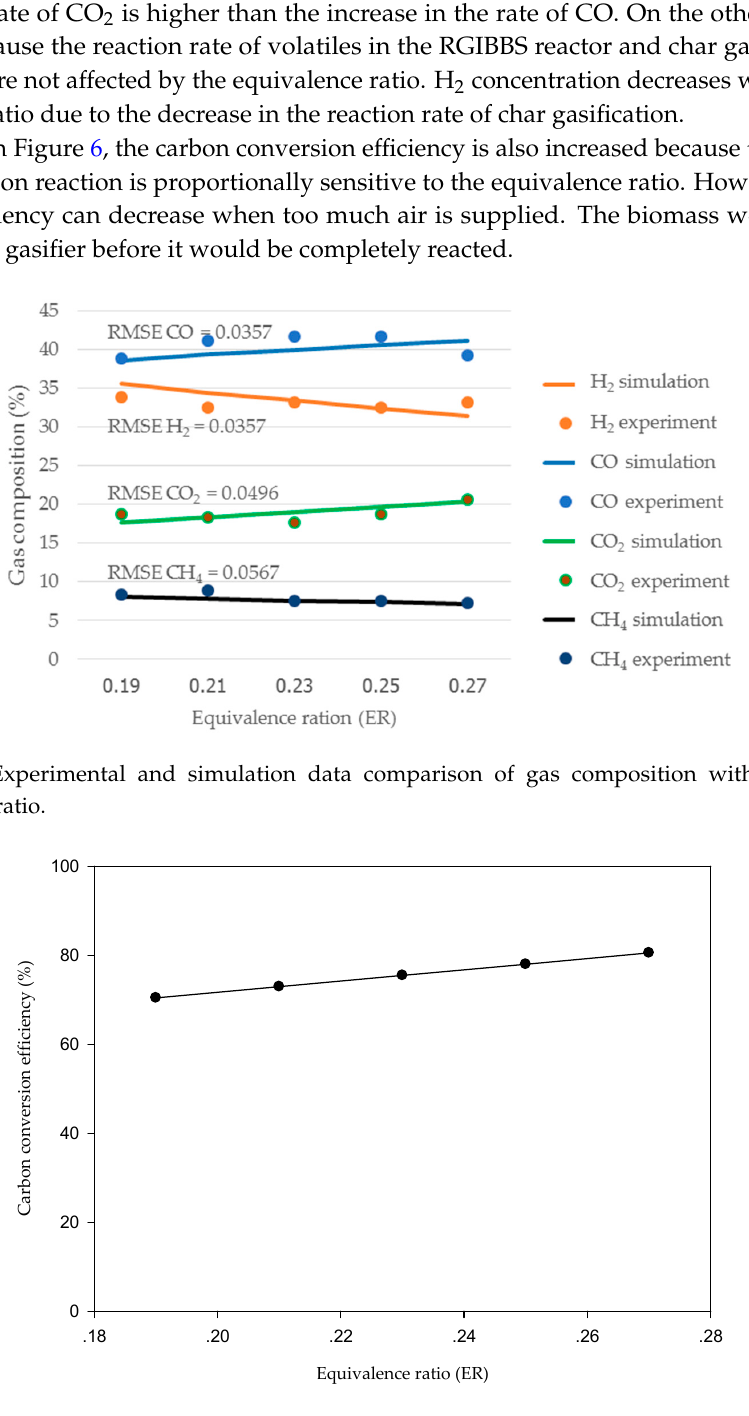
Figure 6. Carbon conversion efficiency with respect to equivalence ratio.